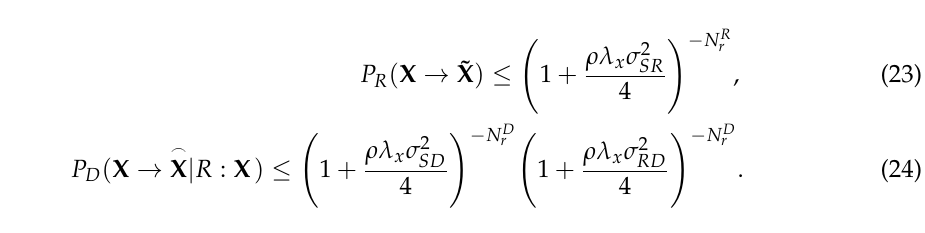
Figure 2. Performance comparison of the STBC-CMIMO system for N S BPSK, QPSK and